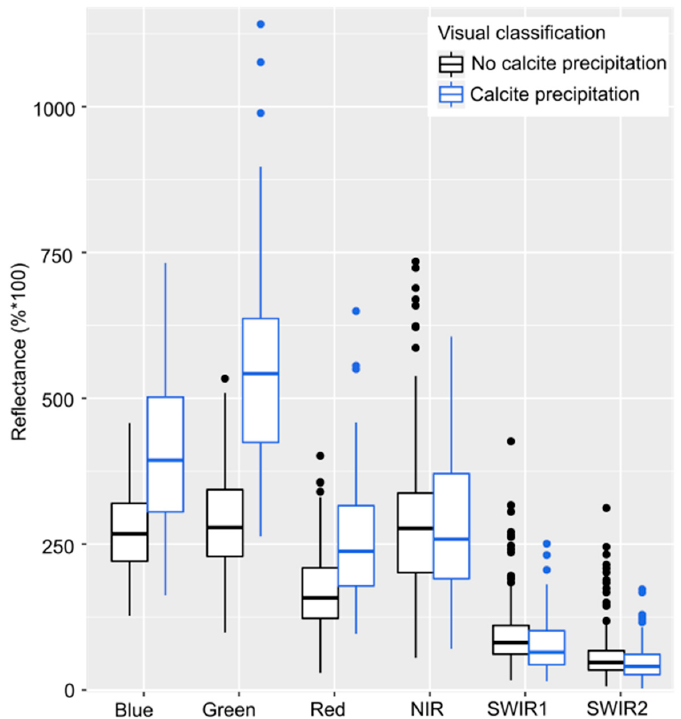
Figure 11. Reflectance values in all spectral bands of Breiter Luzin, Schmaler Luzin and Feldberger Haussee of good quality images. All three lakes are visually classified as turquoise (calcite precipitation) or dark (no calcite precipitation).